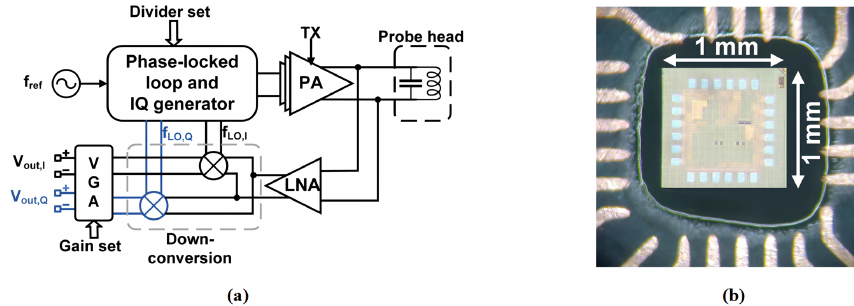
Figure 3. (a) Block diagram of the custom CMOS transceiver chip. (b) A micrograph of the chip attached to the PCB-based NMR-probe